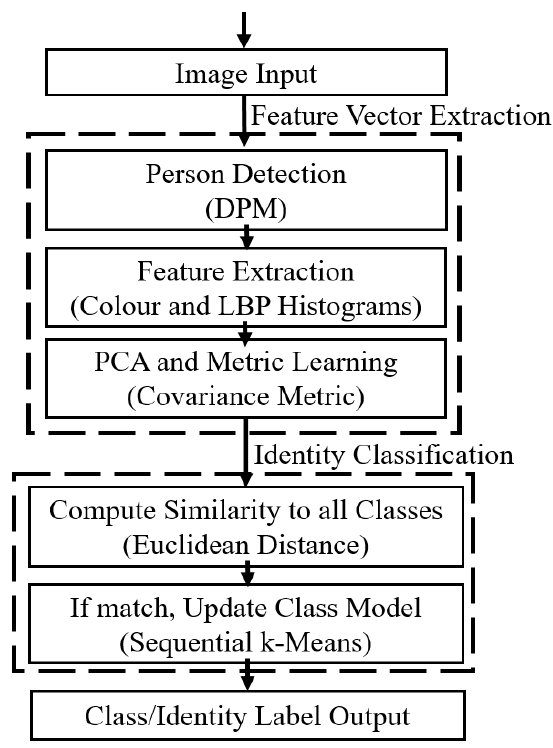
Figure 2. The feature extraction and identity classification processes in the appearance